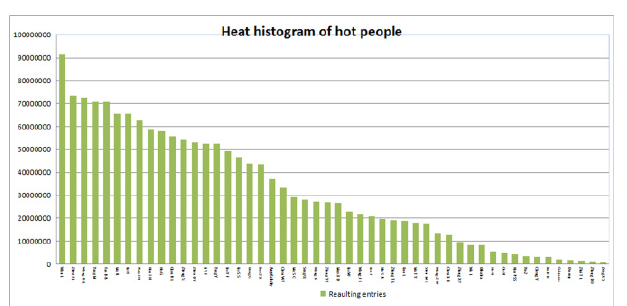
Fig. 3. Heat Histogram of Hot